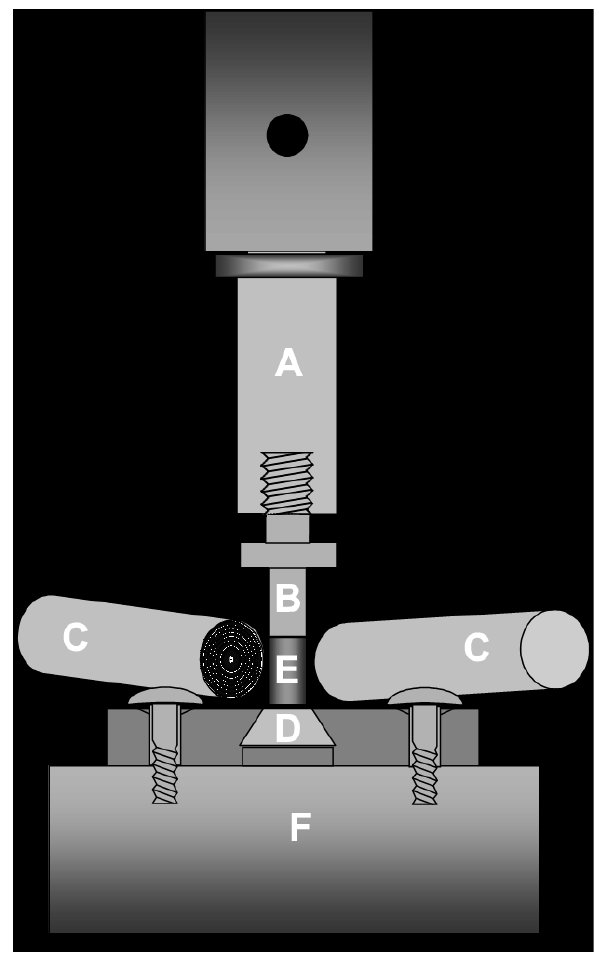
FIGURE 1- Polymerization stress testing configuration. (A) upper portion of the system, connected to the load cell; (B) cylindrical metallic device; (C) photoactivation units in position; (D) lower metallic mould with central hole; (E) composite specimen; (F) lower portion of the